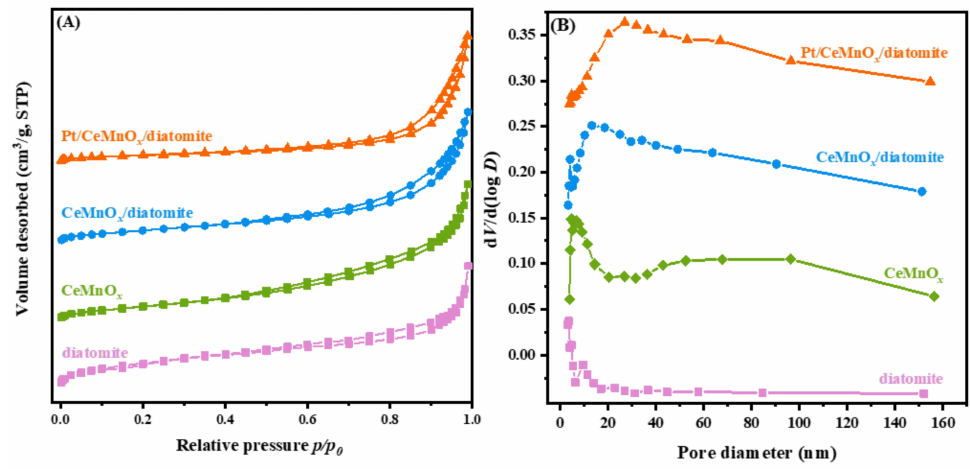
Figure 3. ( A ) Nitrogen adsorption–desorption isotherms and ( B ) pore-size distributions of the samples.